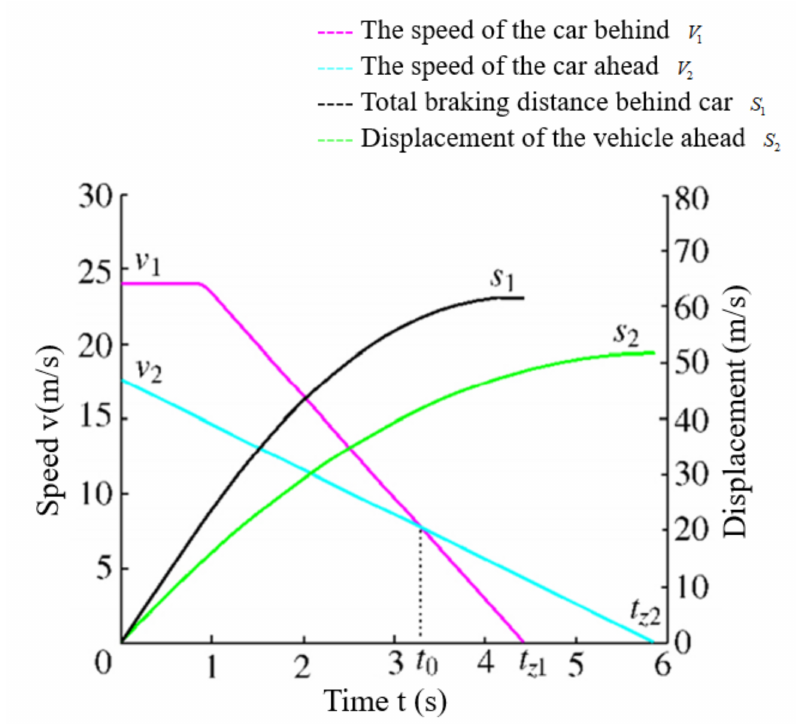
Figure 17. Velocity—displacement variation diagram.